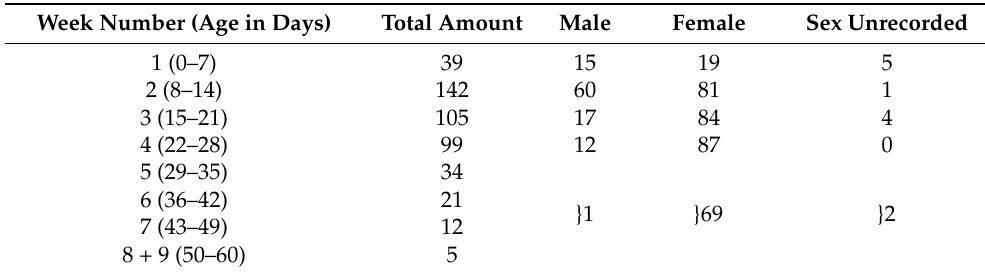
Table 1. Distribution of platelet and leukocyte counts of calves at age of sampling and sex, in the field